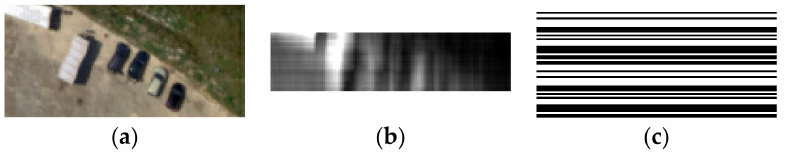
Figure 4. ( a ) an example of a 31-band, visible light, airborne hyperspectral image, showing vehicles parked on a concrete pad. ( b ) Simulation of the central portion of the same image viewed through a sensor of the type considered in this paper. The “blurring” is due to multiple wavelengths overlapping at the focal plane, while some faint horizontal stripes are visible due to the aperture code. Note that multiple frames of this type are required to reconstruct the full hyperspectral image. ( c ) The aperture code used to simulate ( b